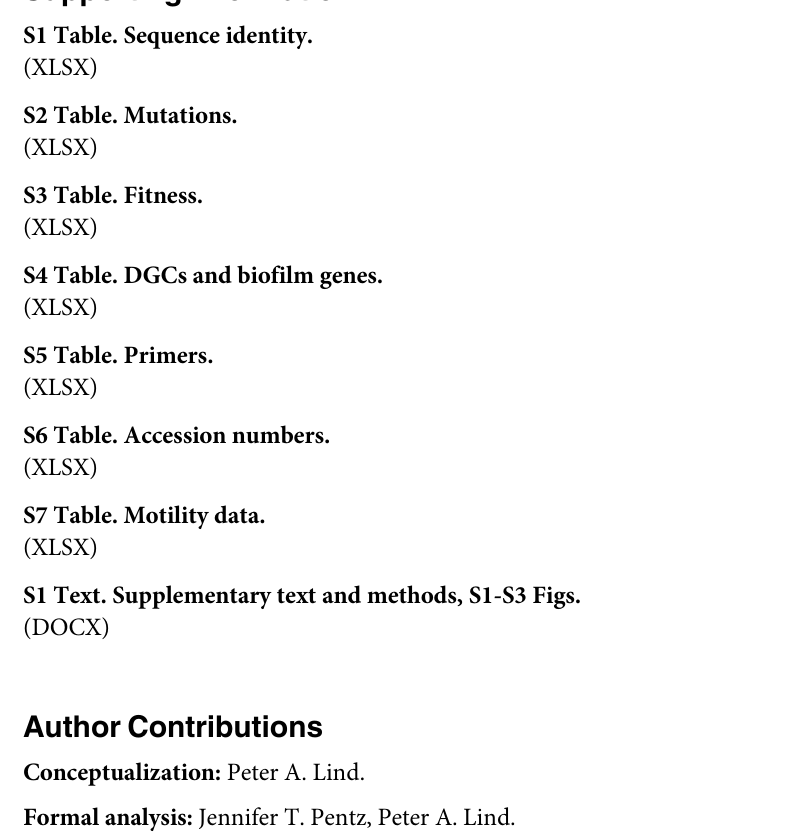
S3 Table. Fitness. S4 Table. DGCs and biofilm genes. S5 Table. Primers. S6 Table. Accession numbers. S7 Table. Motility